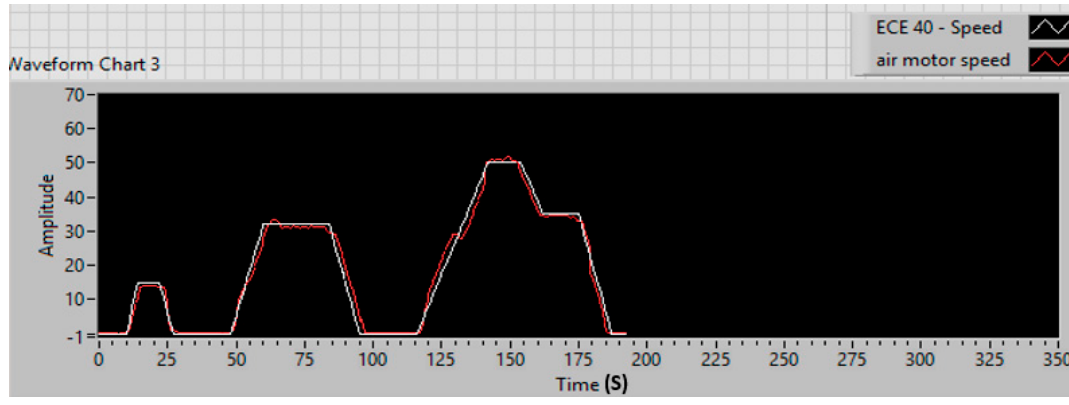
Figure 11. Experimental results of HPPS driving cycle.